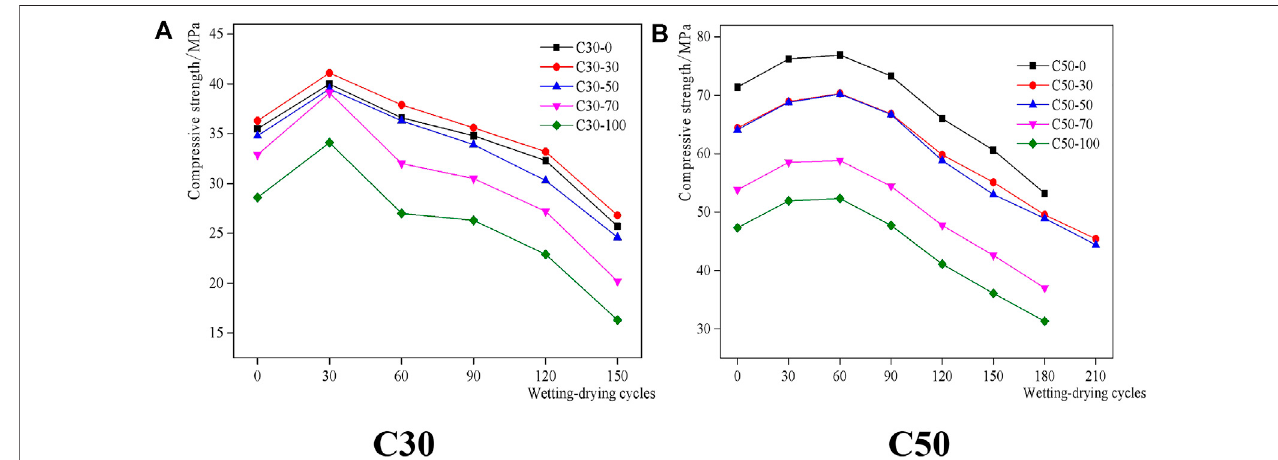
FIGURE 1 | Compressive strength of concrete after different wetting – drying cycles.